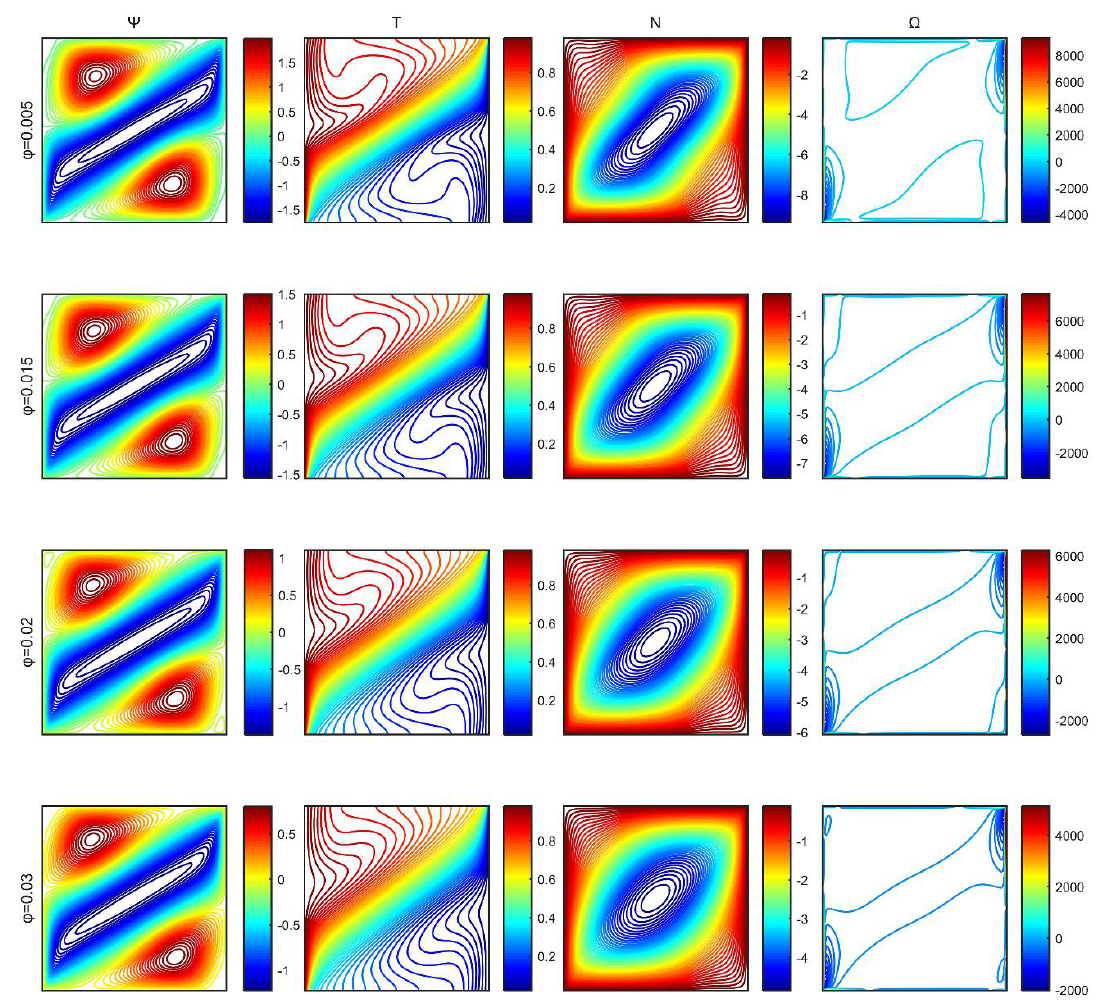
Figure 10. Stream function ( Ψ ), temperature ( θ ), microrotation ( N ), and vorticity ( Ω ) contour plots Figure 10. Stream function ( 𝛹 ), temperature ( 𝜃 ), microrotation ( 𝑁 ), and vorticity ( 𝛺 ) contour plots for for characteristic volume fractions of the characteristic volume fractions of the nanoparticles.